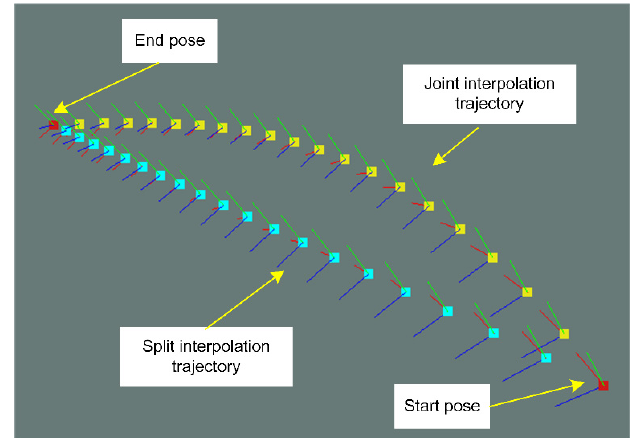
Figure 3. Comparison of split and joint interpolation trajectories.